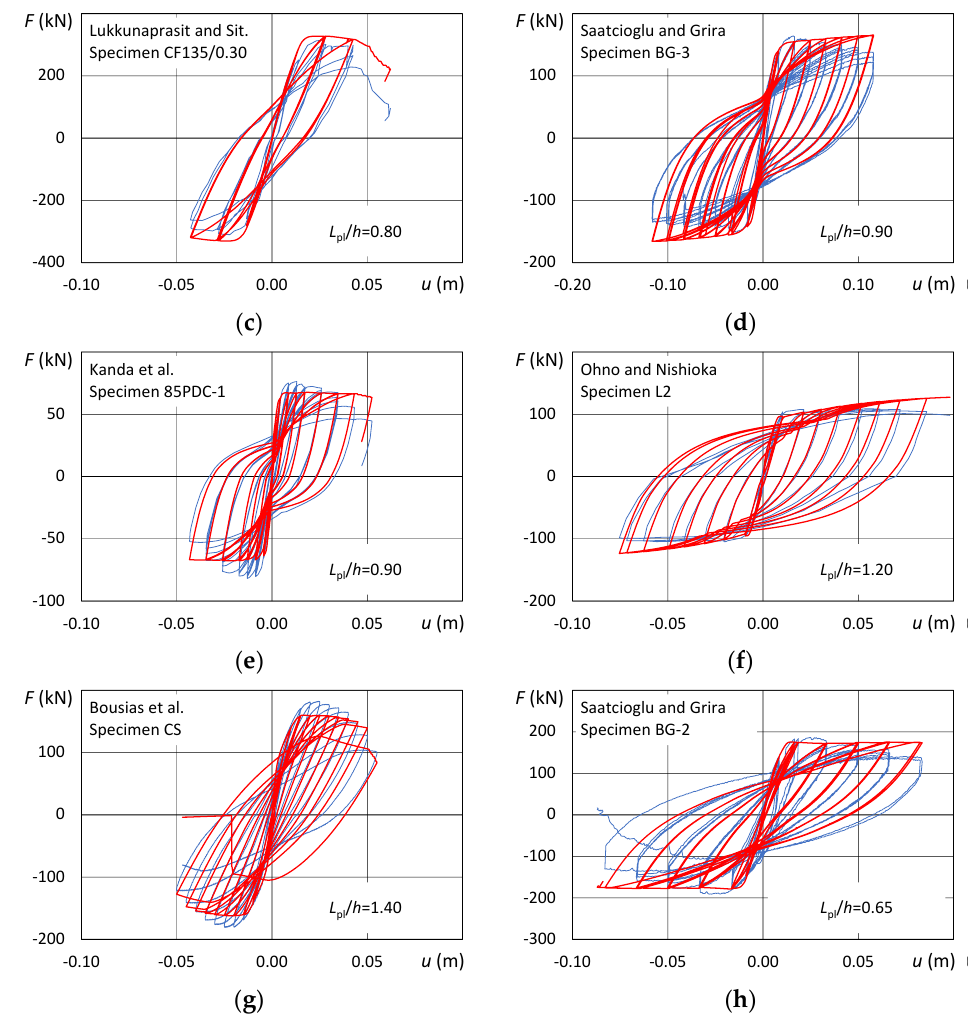
Figure 7. Comparison between laboratory tests and numerical analyses for the specimen tested by (a) Saatcioglu and Ozcebe [36], (b) Bousias et al. [35], (c) Lukkunaprasit and Sittipunt [41], (d) Saatcioglu and Grira [37], (e) Kanda et al. [39], (f) Ohno and Nishioka [40], (g) Bousias et al. [34] and (h) Saatcioglu and Grira [37]; Notes: (blue line) laboratory test; (red line) numerical analysis.